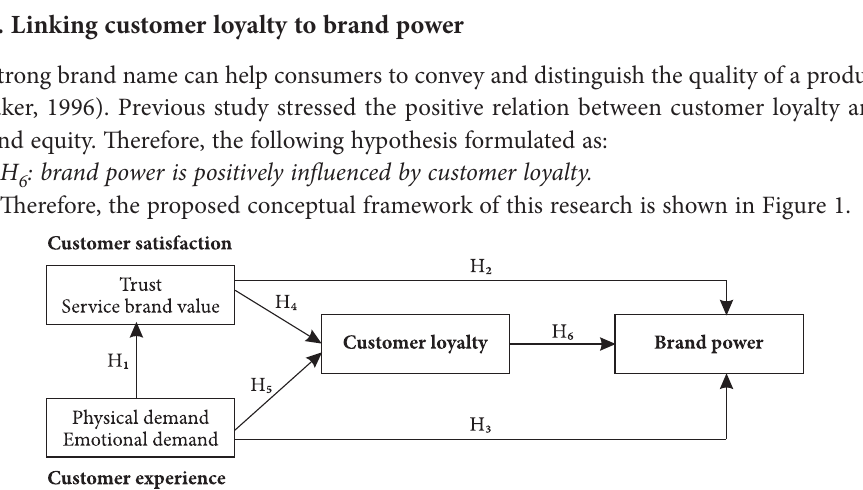
Figure 1. Model and hypothesized relationships